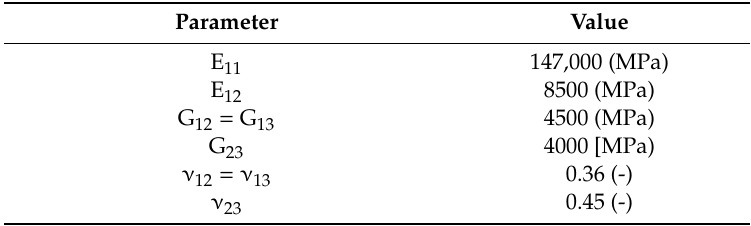
Table 1. Material